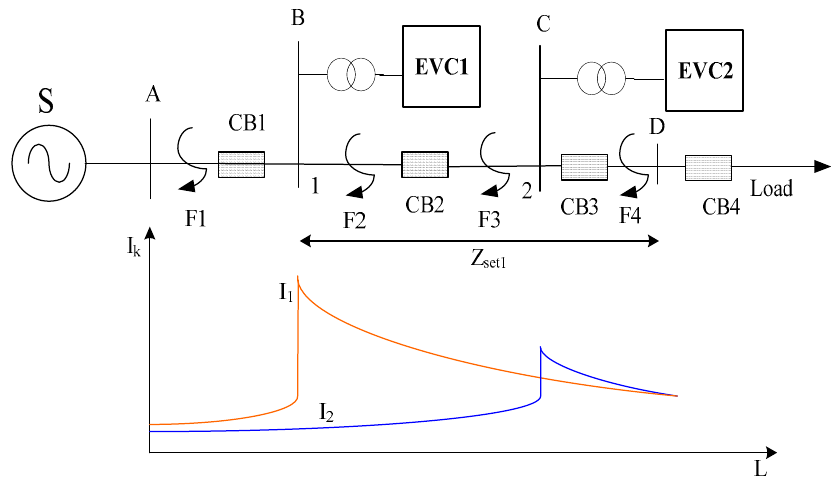
Figure 6. Schematic diagram of three-phase short-circuit fault protection.